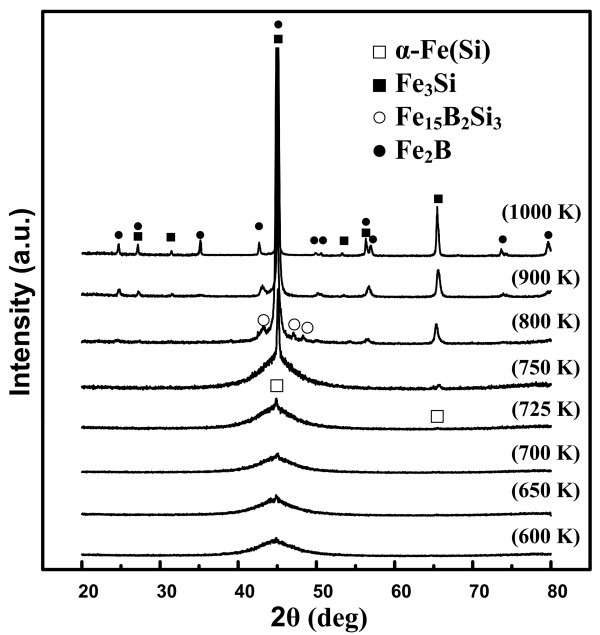
XRD patterns for the Fe78B13Si9 substrates annealed at various temperatures for 10 min and then after the wetting at 600 K for 1 h.